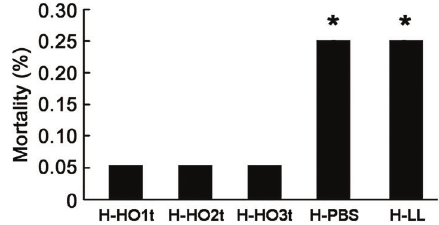
Figure 1. Mortality in hemorrhagic shock (H groups) treated once with Lactococcus lactis expressing heme oxygenase-1 (H-HO1t), twice (H-HO2t), three times (H-HO3t) or treated with phosphate- buffered saline (PBS) and L. lactis (LL). * P o 0.05: compared to the remaining groups